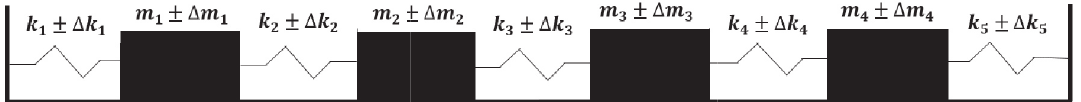
Fig. 7. Spring-mass